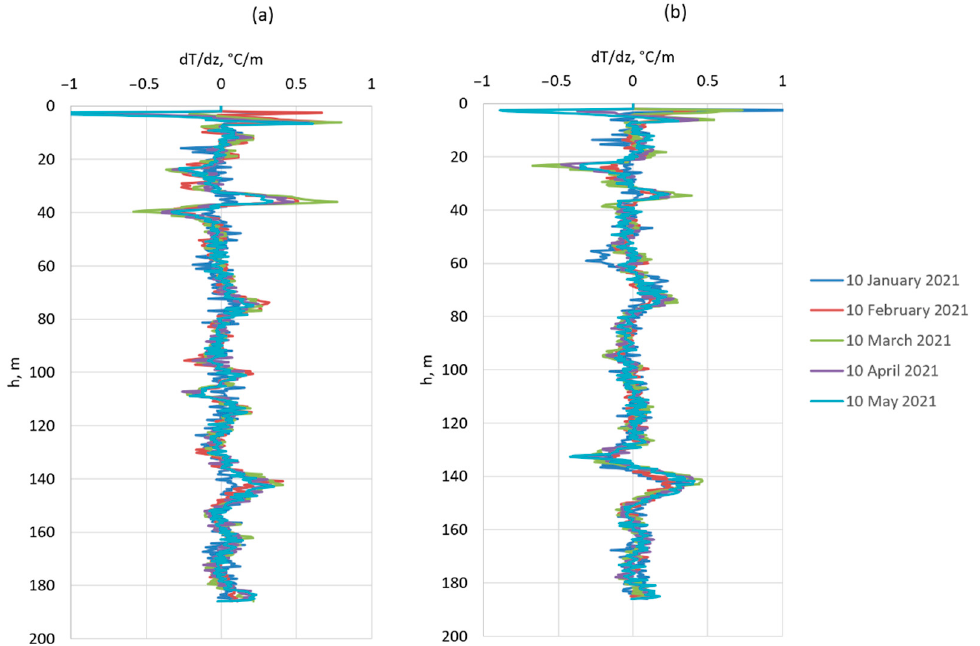
Figure 3. Distributions of temperature gradients along the depth of TC-1 ( a ) and TC-2 ( b )